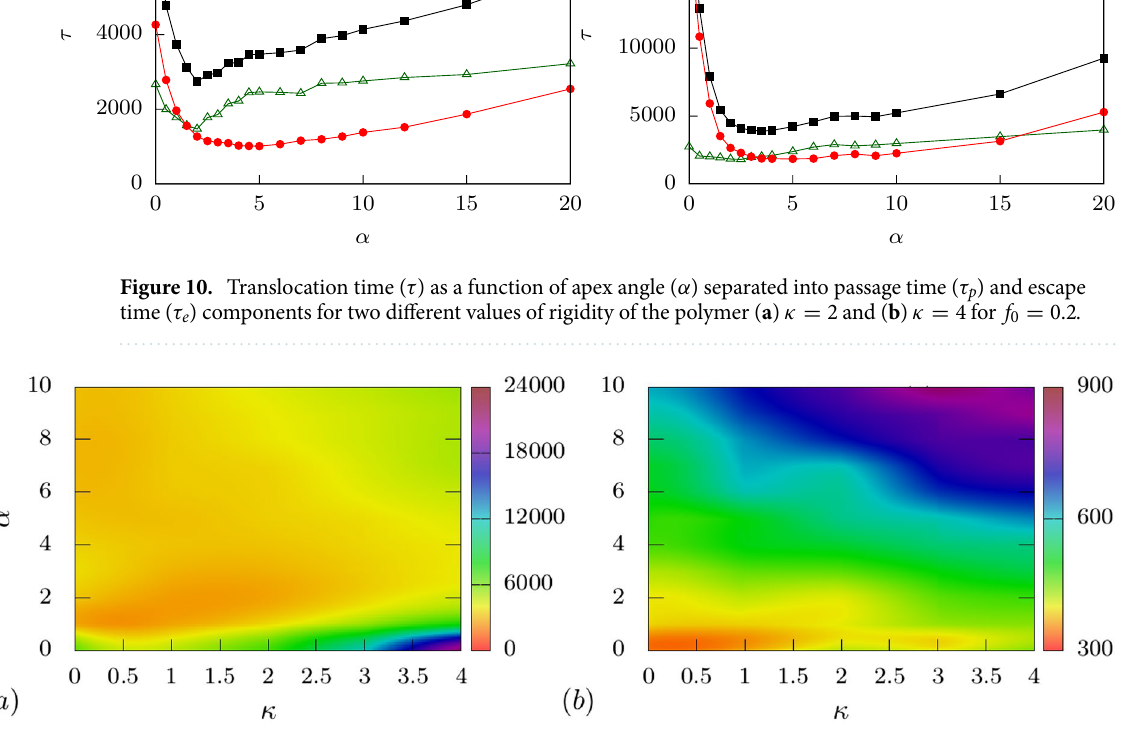
Figure 11. Phase plot of total translocation time τ in the κ − α plane for two forces ( a ) f 0 = 0.2 and ( b ) f 0 = 1.0